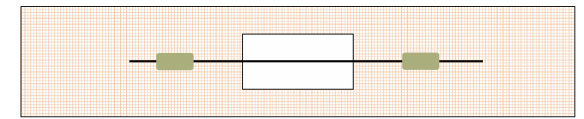
Figure 2. Schematic diagram of monofilament tensile specimen.